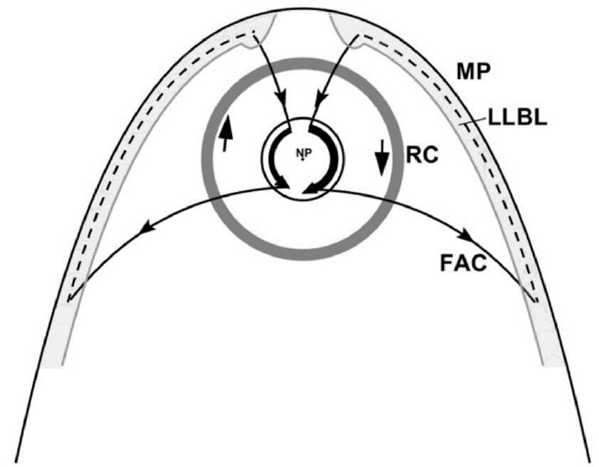
Figure 12. Schematic drawing of the suggested 3D current circuits causing the storm-time disturbance asymmetries. Field-aligned cur- rents flowing out of the dynamo region on the dayside feed the anti- sunward net currents in the polar region. On the nightside FACs lead the currents into the outer magnetosphere on the dawn and dusk flanks. Here the currents are assumed to flow sunward within the low-latitude boundary layer (LLBL) to close the loops. Equivalent current circuits are expected in the Southern